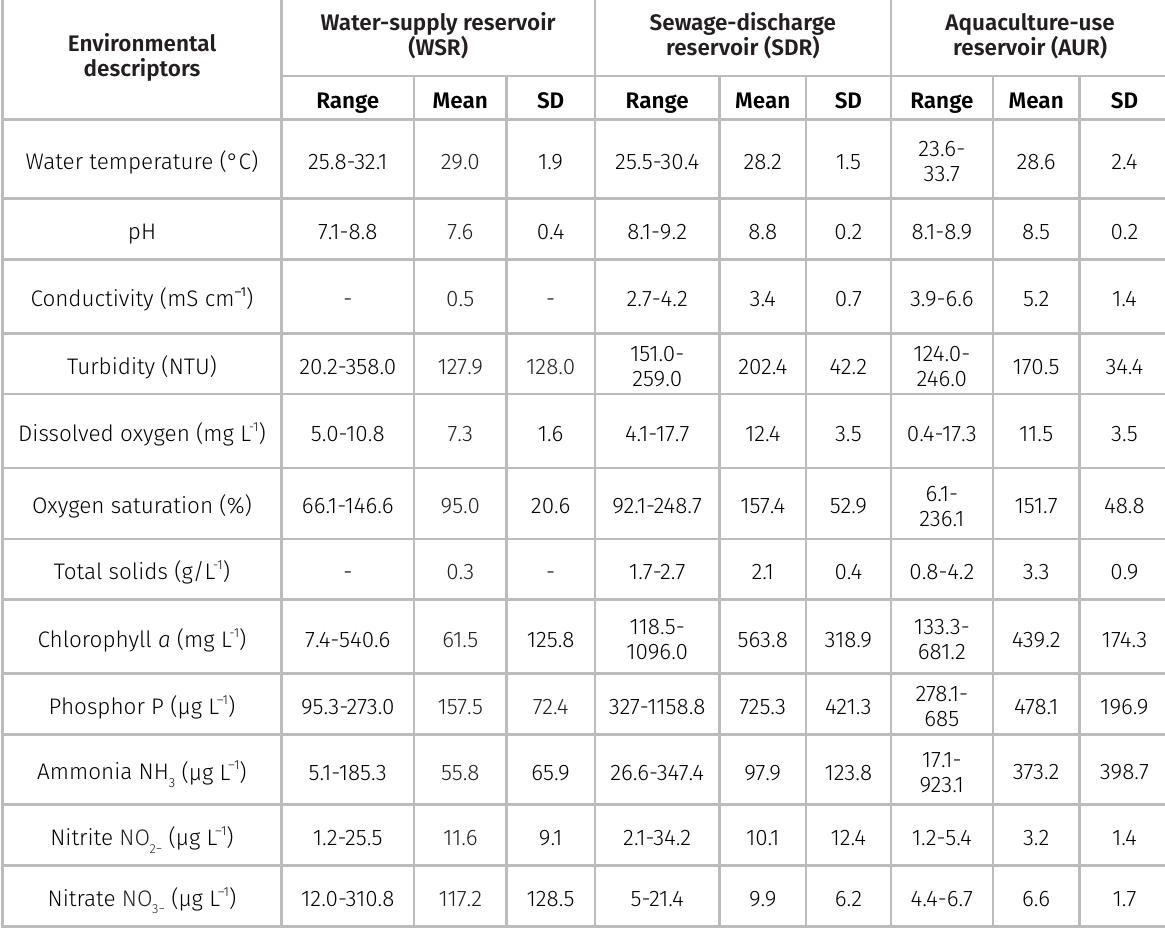
Table I. Ranges (minimum - maxim), means and standard deviations (SD) of the environmental descriptors in the reservoirs of neotropical semiarid ecosystems (Pernambuco,